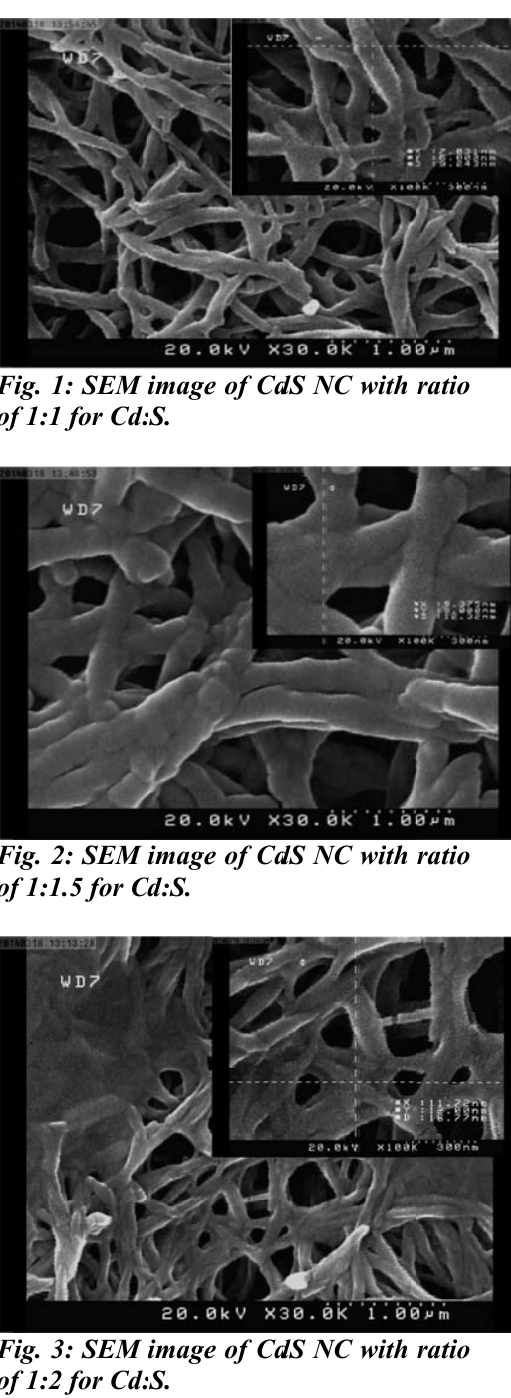
Fig. 3: SEM f 1:2 for Cd: